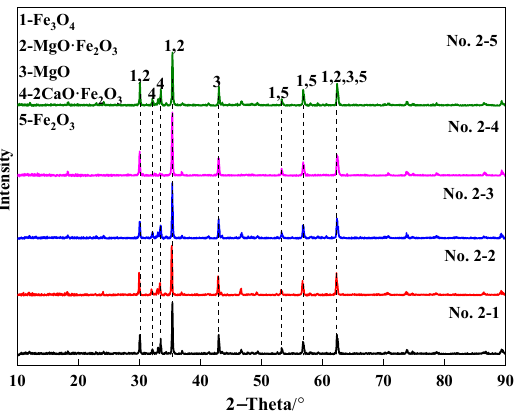
Figure 14. The XRD analysis of Fe 2 O 3 -MgO-CaO of samples after reduction.